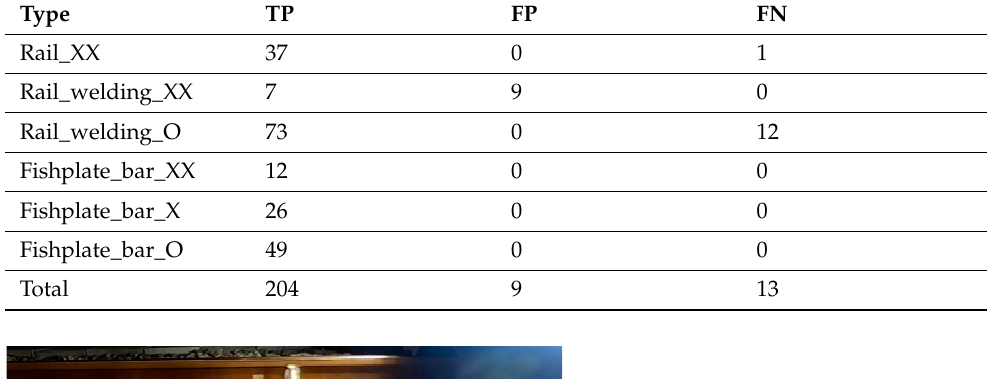
Table 12. YOLOv4-Tiny training results for each defective type in the side view. Table 12. YOLOv4 ‐ Tiny training results for each defective type in the side view.